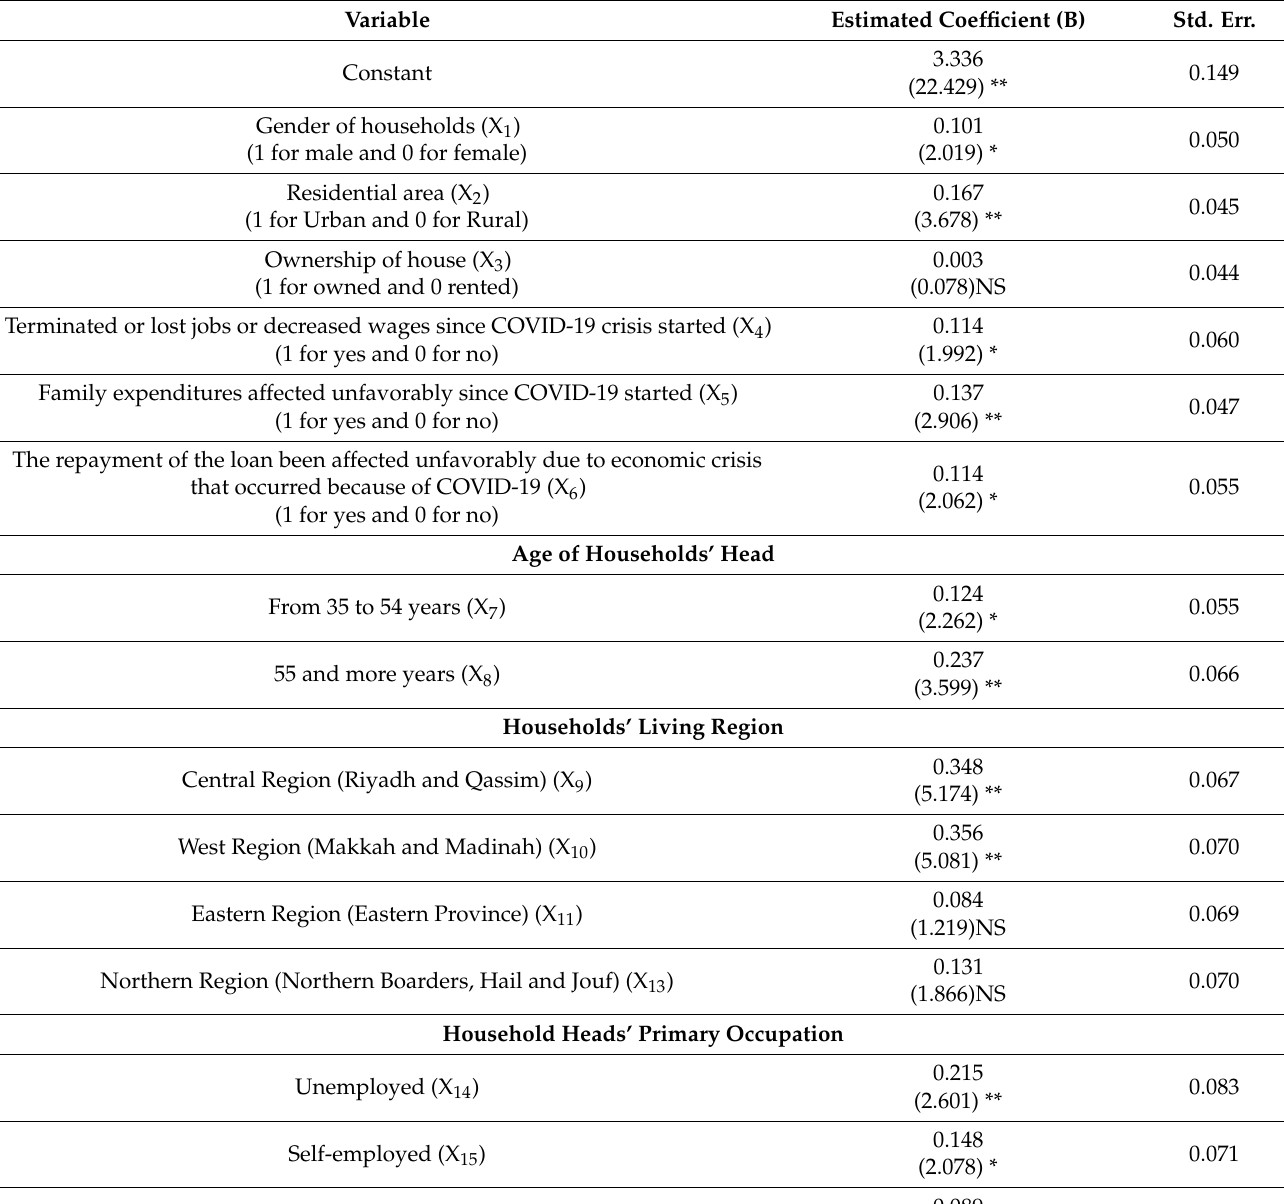
Table 6. Results of the multiple regression analysis for